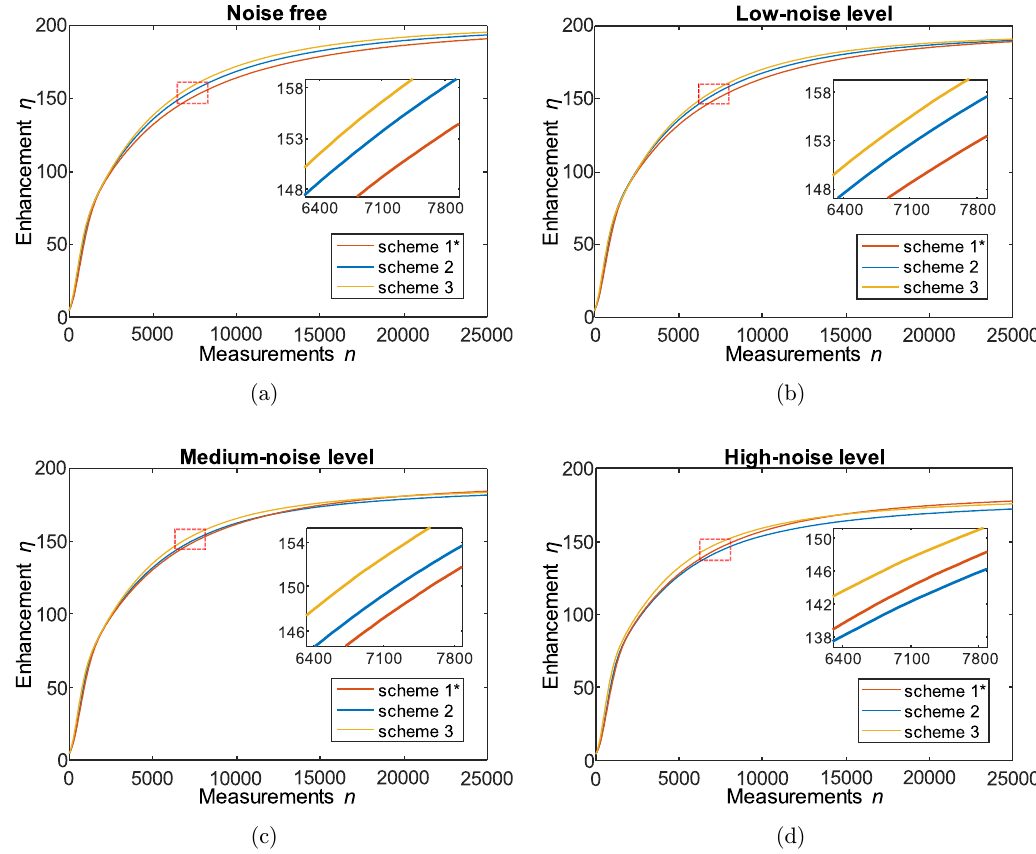
Fig. 2. Comparisons of di®erent schemes to form new generations. Scheme 1 is the one used in Ref. 18, which is marked with an asterisk. (a) – (d) The enhancement as a function of the number of measurements under di®erent conditions: noise free, low-noise level, medium-noise level, and high-noise level. Insets are provided around 7000 measurements for visualization